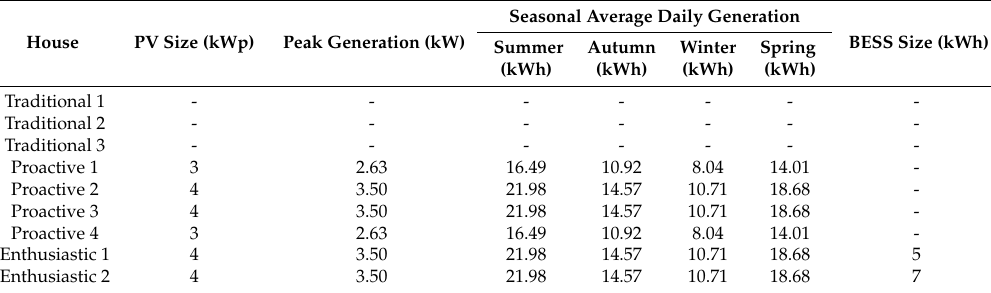
Table 6. Renewable energy profiles of different households in the microgrid.